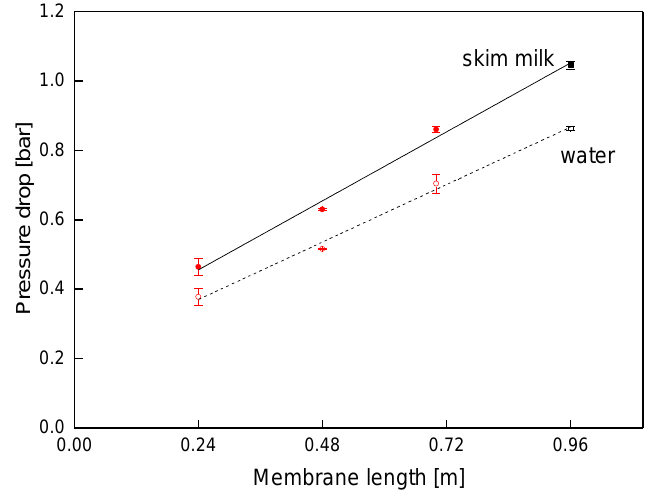
Figure 11. Pressure drop in SWMs of different lengths (red circles: shortened modules; black squares: sectioned membrane) at a mean crossflow velocity of 0.42 m s − 1 .